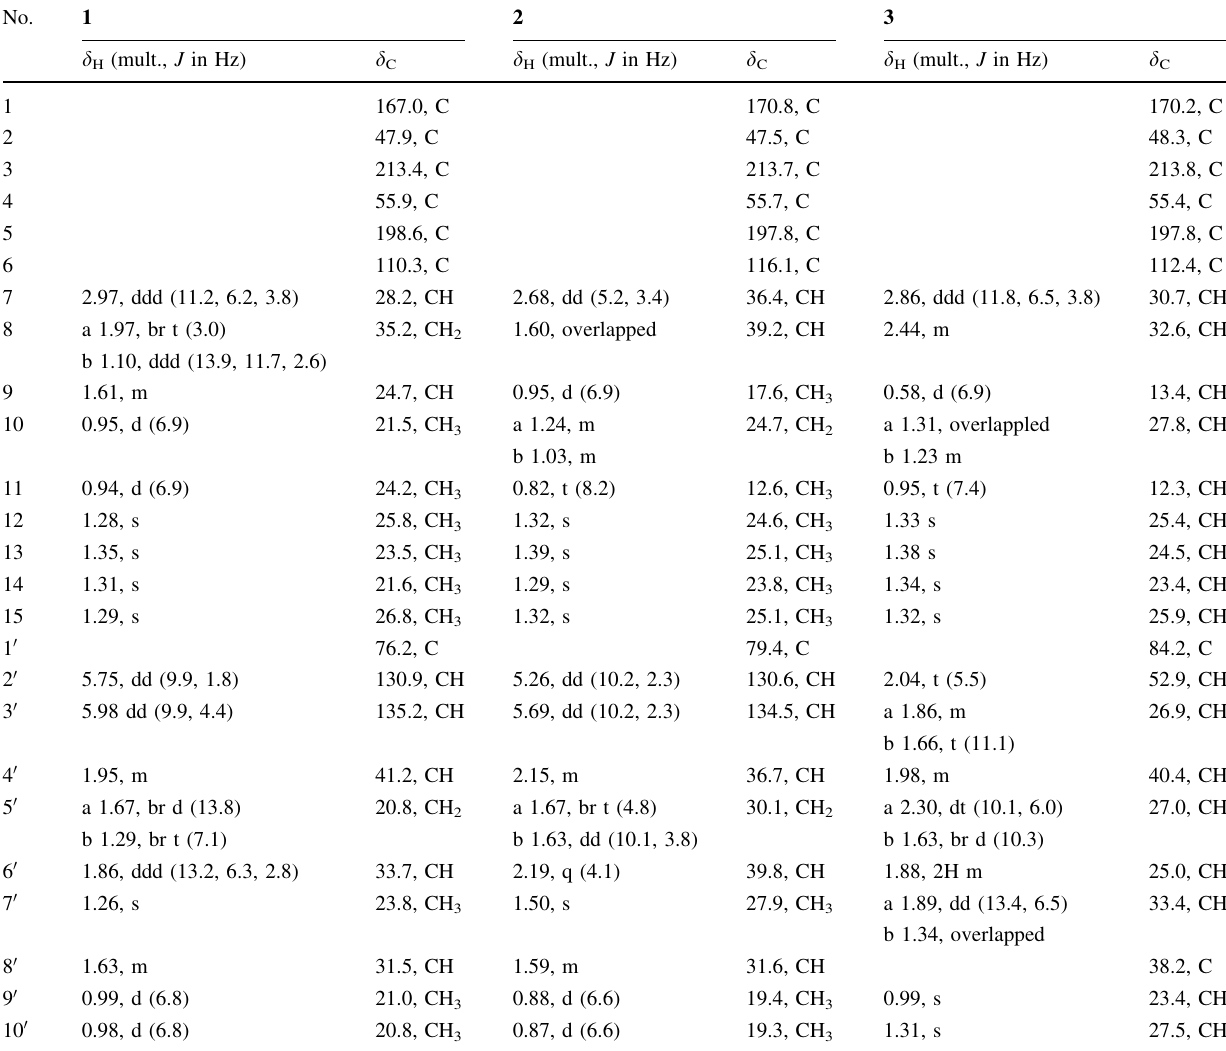
Table 1 1 H (800 MHz) and 13 C (200 MHz) NMR data for 1 – 3 in CDCl 3